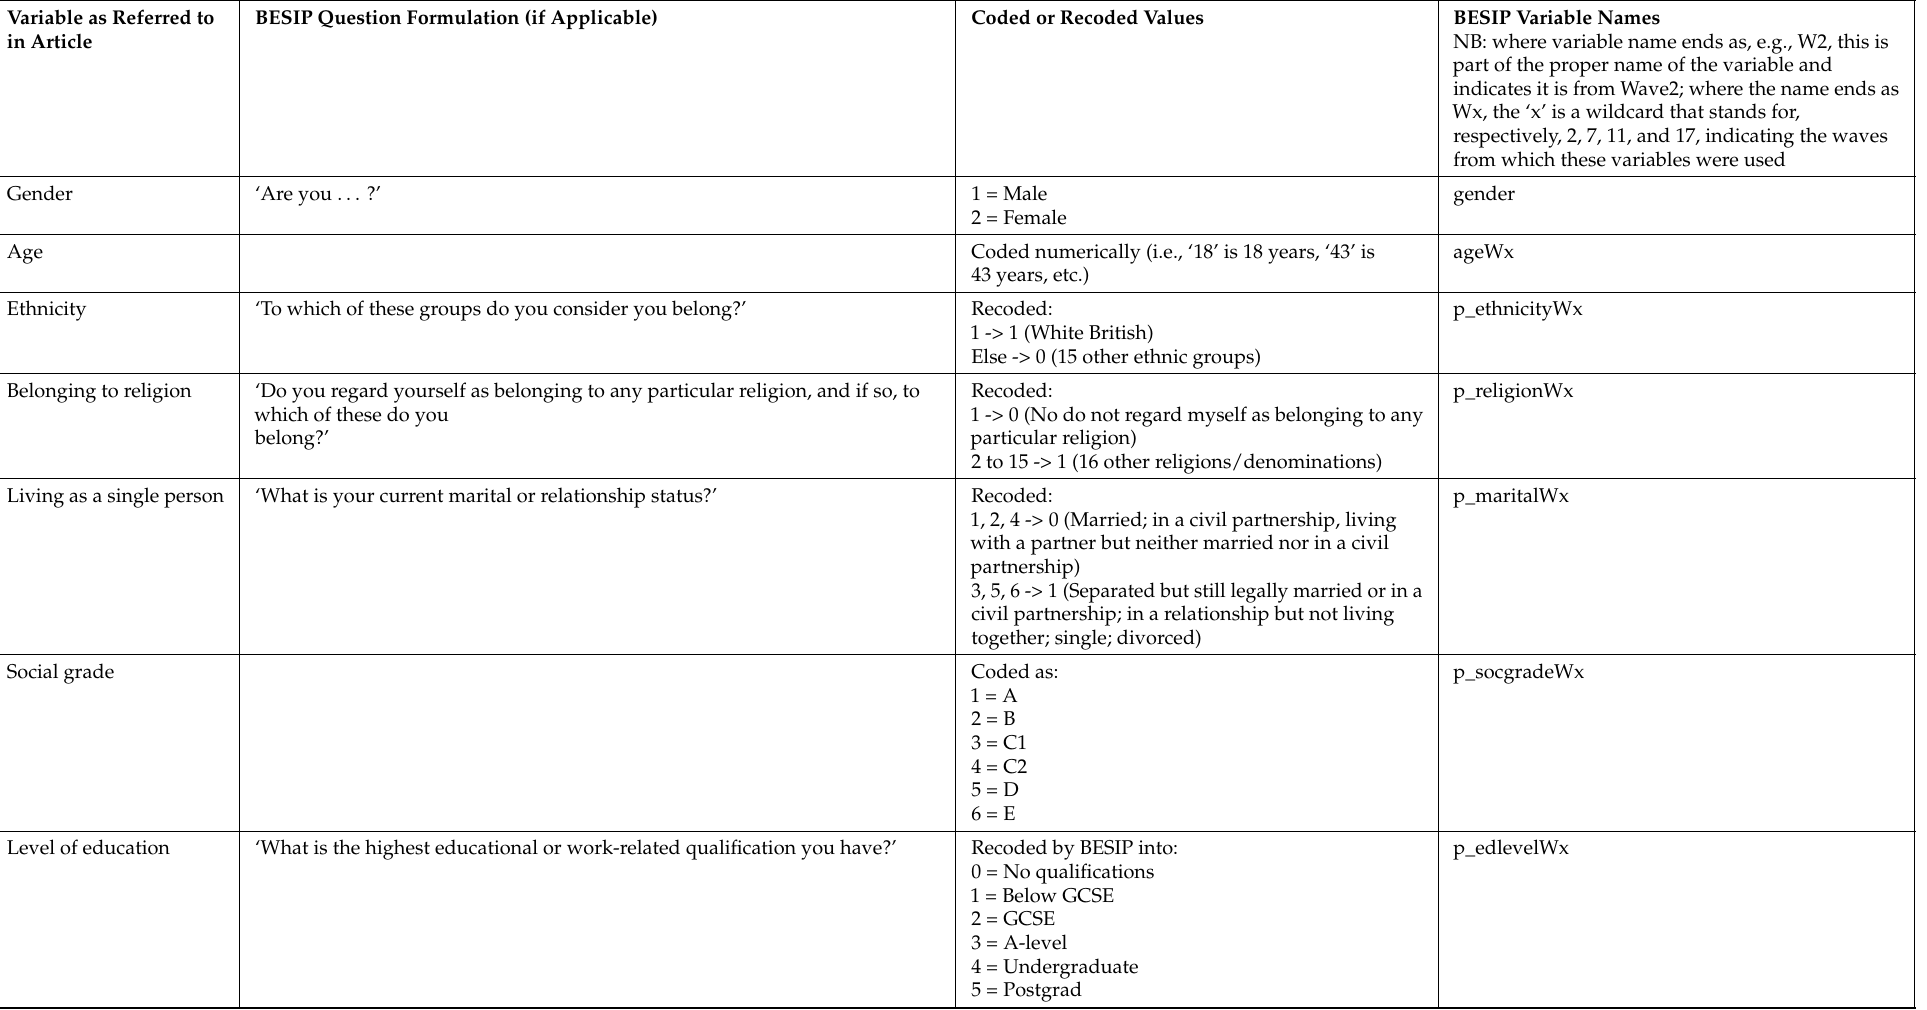
Table A1. Description of variables used in the